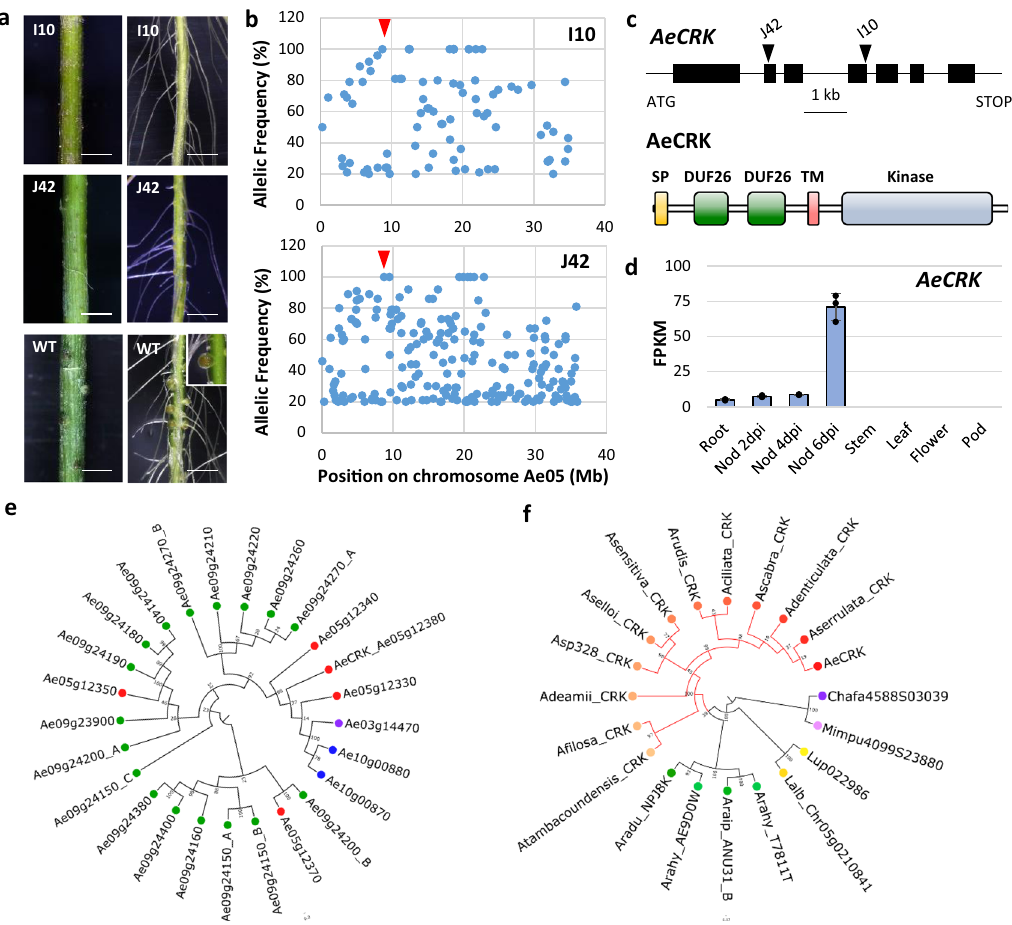
Fig. 7 A gene involved in the establishment of the Nod factor-independent symbiosis identi fi ed by mapping-by-sequencing. a Nodulation phenotypes observed on stem (left) and root (right) in EMS mutant plants and the WT line. Root phenotypes were observed four times and stem phenotypes at least twice for each mutant. Scale bar: 5 mm. b Frequency of the EMS-induced mutant alleles in bulks of Nod − backcrossed F2 plants obtained for the I10 and J42 mutants by mapping-by-sequencing. The SNPs representing the putative causal mutations are indicated by the red arrow head. c AeCRK gene and protein structure. Upper panel: the AeCRK gene exons are indicated by black boxes and the position of the EMS mutations indicated by triangles. Lower panel: the predicted AeCRK protein contains a signal peptide (SP), followed by two cysteine-rich domains of unknown function (DUF26), a transmembrane domain (TM), and a kinase domain. d AeCRK expression pattern in A. evenia aerial organs, root, and during nodule (Nod) development after inoculation (dpi) with the Bradyrhizobium strain ORS278. Expression is given in normalized FPKM read counts. For root and nodule samples, data correspond to mean values of three biological replicates ± SEM and dots represent individual expression levels. e Phylogenetic tree of the CRK gene family in A. evenia . In total, 25 CRK genes were identi fi ed and found to be located either as a singleton on the Ae03 chromosome (purple), in tandem on the Ae10 chromosome (blue) or in clusters on the Ae05 and Ae09 chromosomes (red and green, respectively). f Phylogenetic tree of AeCRK orthologous genes present in